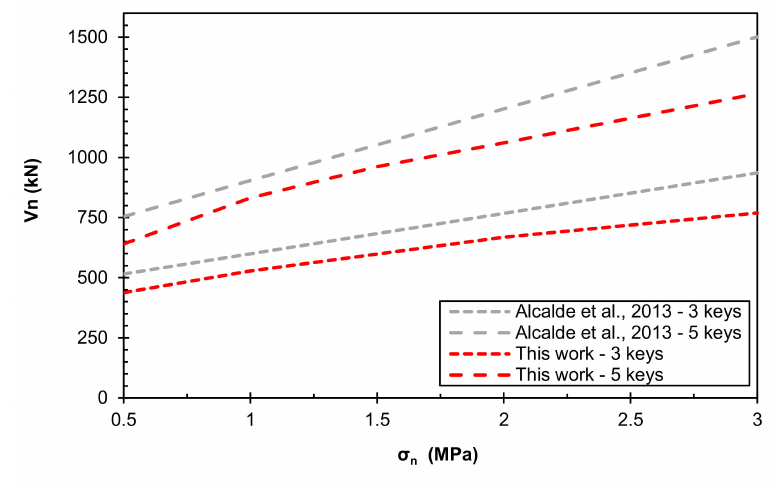
Figure 4. Nominal shear capacity as a function of prestress, V f = 0.0%.